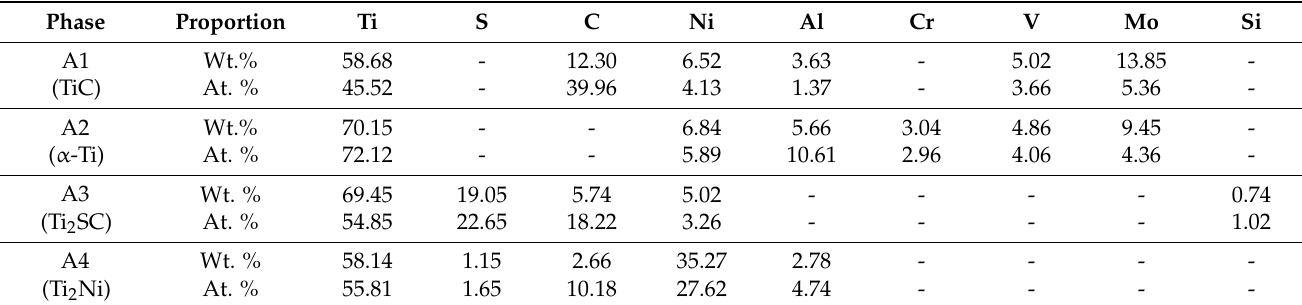
Table 5. The EDS results of the phases in the